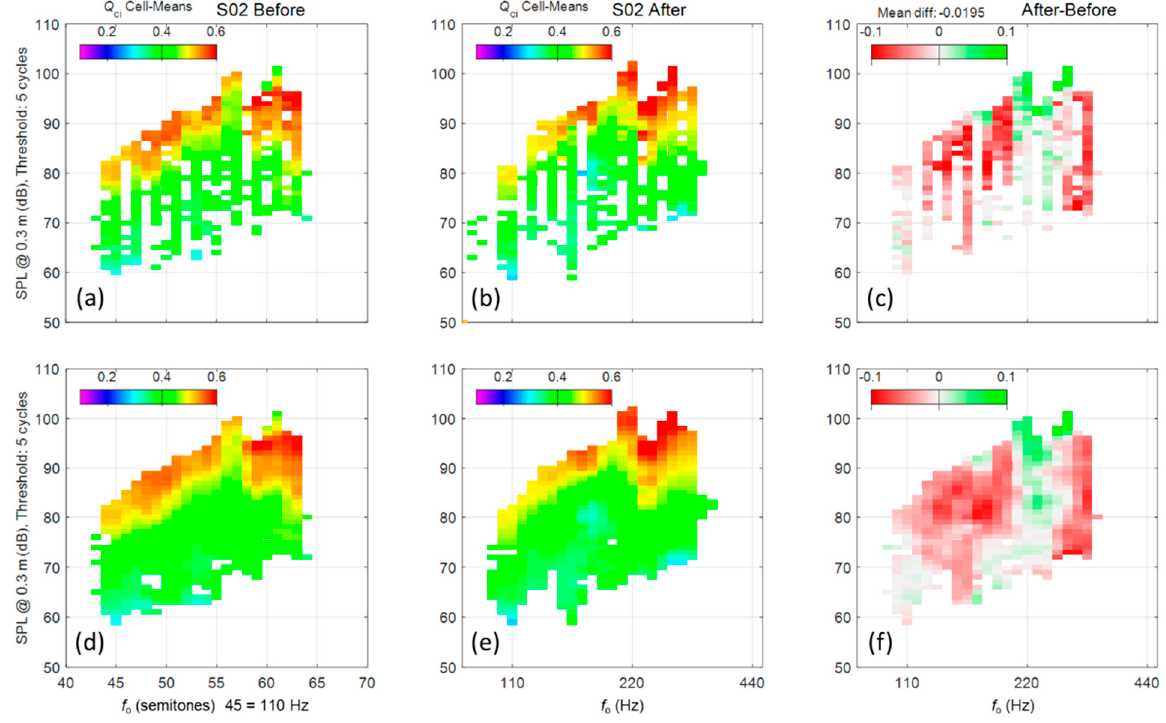
Figure 6. Top row: maps of the EGG contact quotient Q ci ( a ) pre-intervention, ( b ) post-intervention and ( c ) of the difference, to facilitate a comparison across the intervention. The horizontal color bars show the color scale for Q ci (left, center) or for the change in Q ci (right). In ( c ), the color red signifies a reduction in Q ci after the intervention. Bottom row: the same data, after 2D interpolation and smoothing with a convolution kernel of 3 × 3 cells. Interpolation into empty cells is done only if there are non-empty neighbouring cells on opposing sides or corners. Although this does not add more information, the graph is easier to interpret, and the difference map ( f ) from the two interpolated maps ( d , e ) is less vulnerable to missing data in either of ( a ) or ( b ). Data adapted from [44].